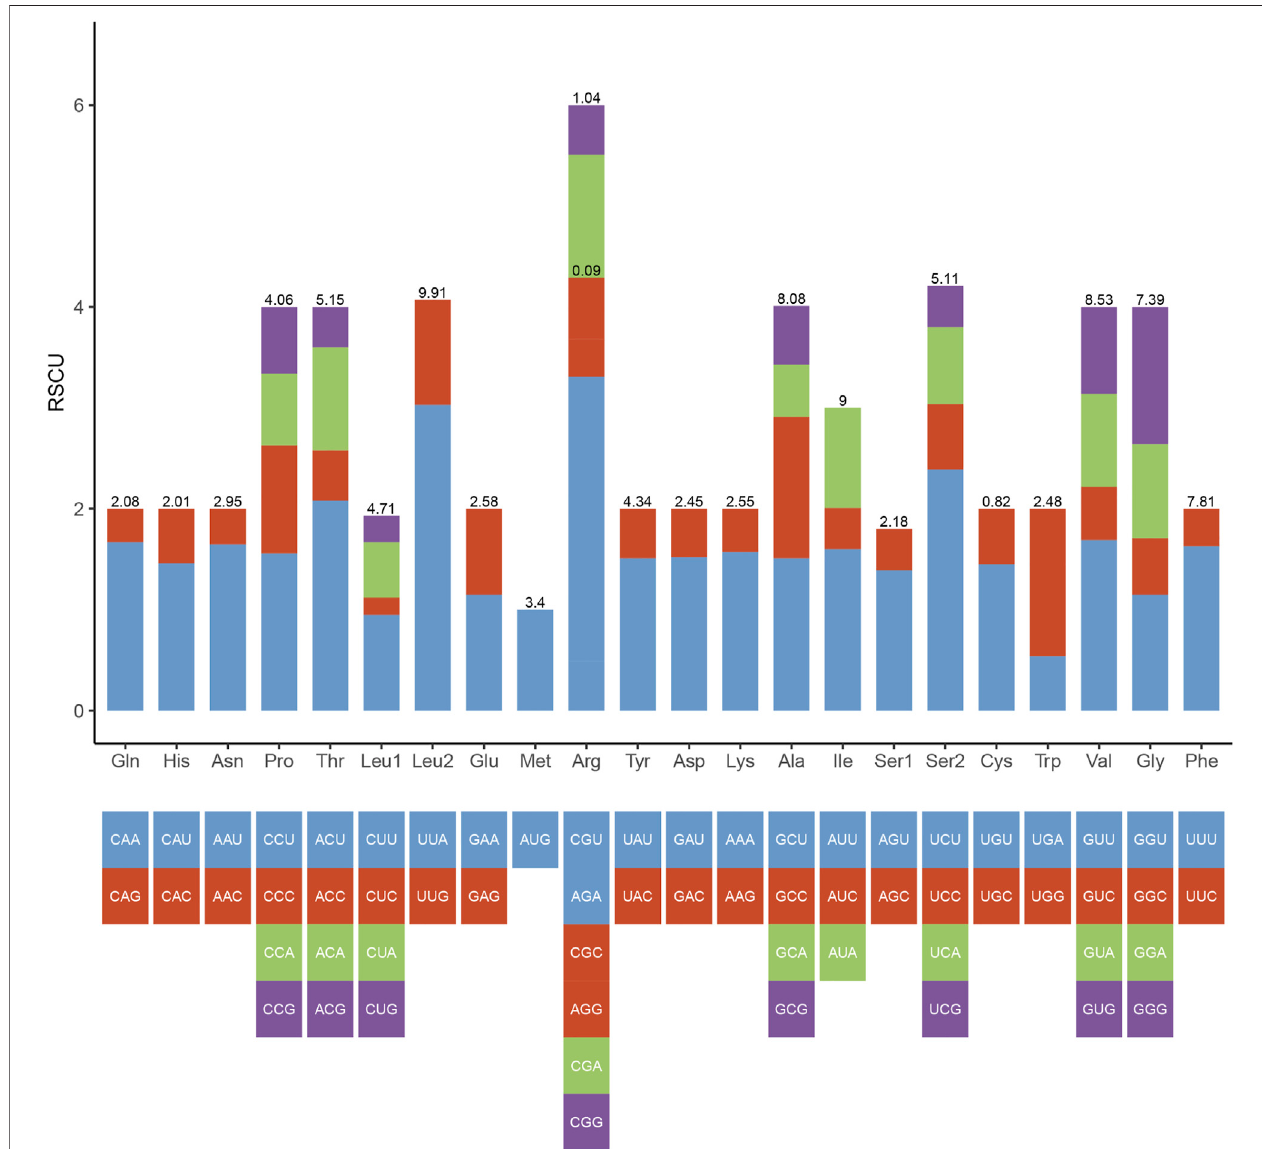
FIGURE 3 | Codon number and relative synonymous codon usage (RSCU) in Galatheanthemum sp. MT-2020 mitochondrial PCGs.